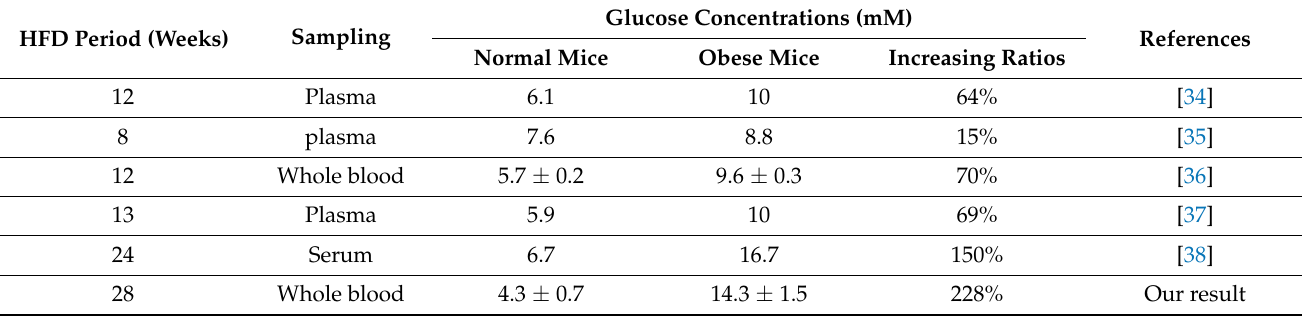
Table 3. Comparison of glucose concentrations in blood samples of mice with previously reported concentrations. HFD Period (Weeks)